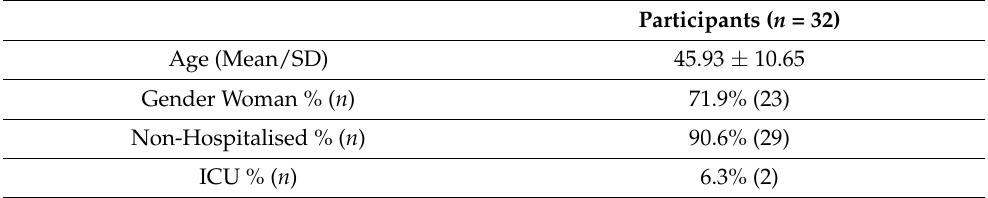
Table 1. Participants characteristics.